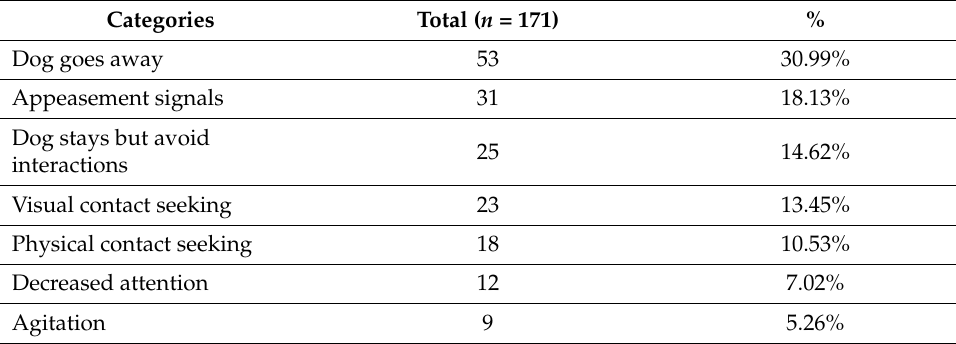
during sessions; n = 171 terms coded.